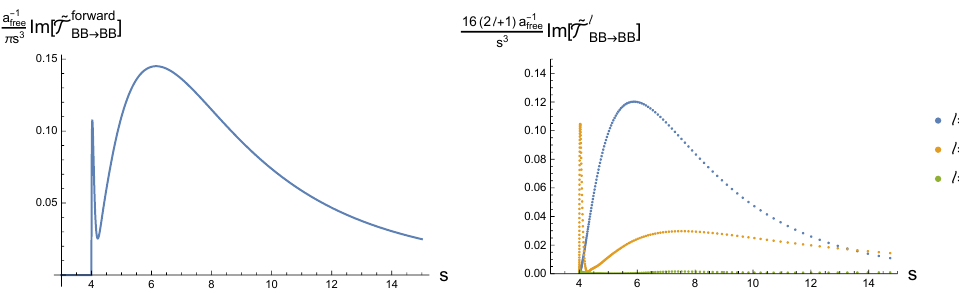
Figure 16 . Left plot: integrand appearing in the sum-rule (3.57) for the absolute minimum of the a -anomaly. Numerical integration of this function leads to a/a free = 1 . 2002 . Right plot: integrand appearing in the sum-rule (3.58) for the absolute minimum of the a -anomaly. Numerical integration of this function leads to a/a free = 0 . 71146+0 . 45094+0 . 03238+ . . . = 1 . 19477+ . . . , where the three entries correspond to spin 0, 2 and 4 respectively and the dots indicate higher spin contributions. The plots are constructed at N max = 20 and L max = 30